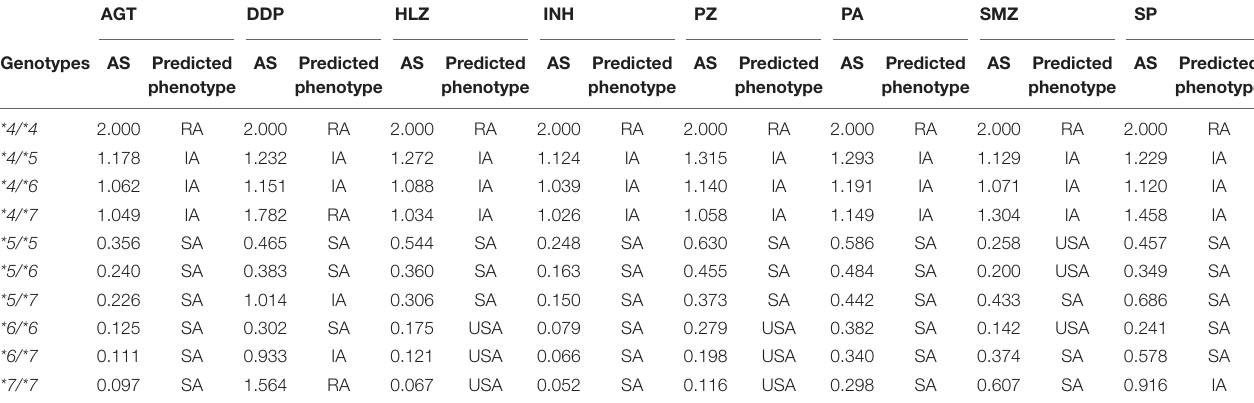
TABLE 3 | Activity scores based on the values of intrinsic clearance and prediction of NAT2 phenotypes for eight drugs. AGT DDP HLZ INH PZ PA SMZ SP